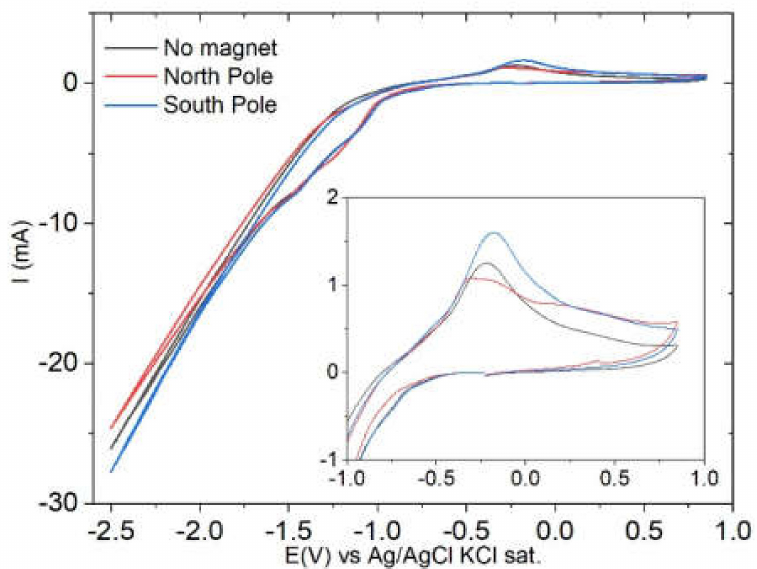
Figure 2. Cyclic voltammetry of the Heusler electroplating solution on the gold substrate in the absence and presence of the magnet under the electrode. Scan rate: 50 mV/s. A magnification of the anodic peach is reported in the